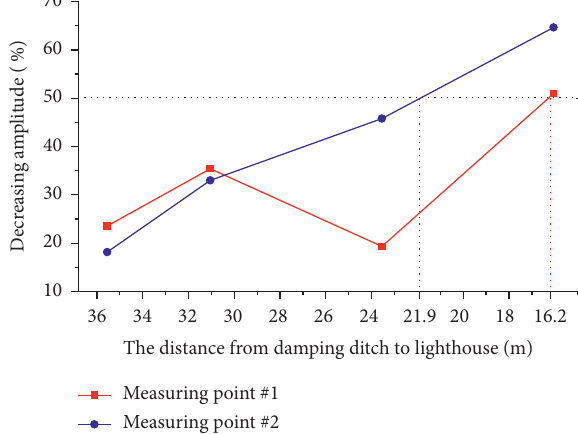
Figure 12: Damping ditch position versus decreasing